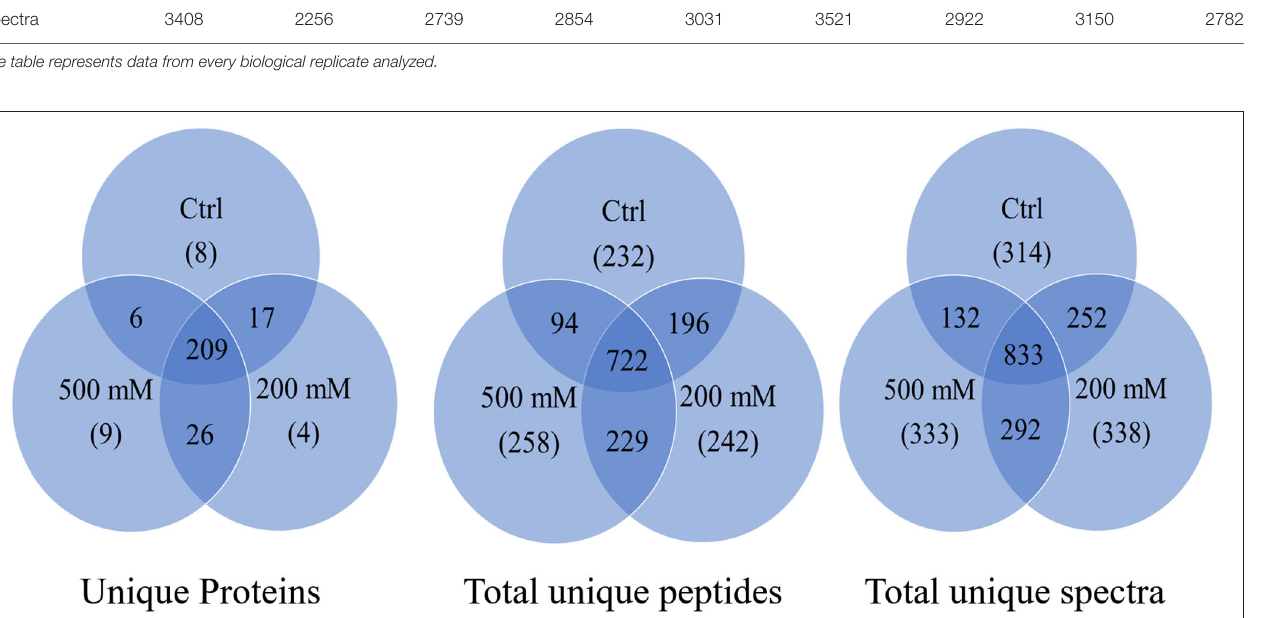
Frontiers in Sustainable Food Systems |